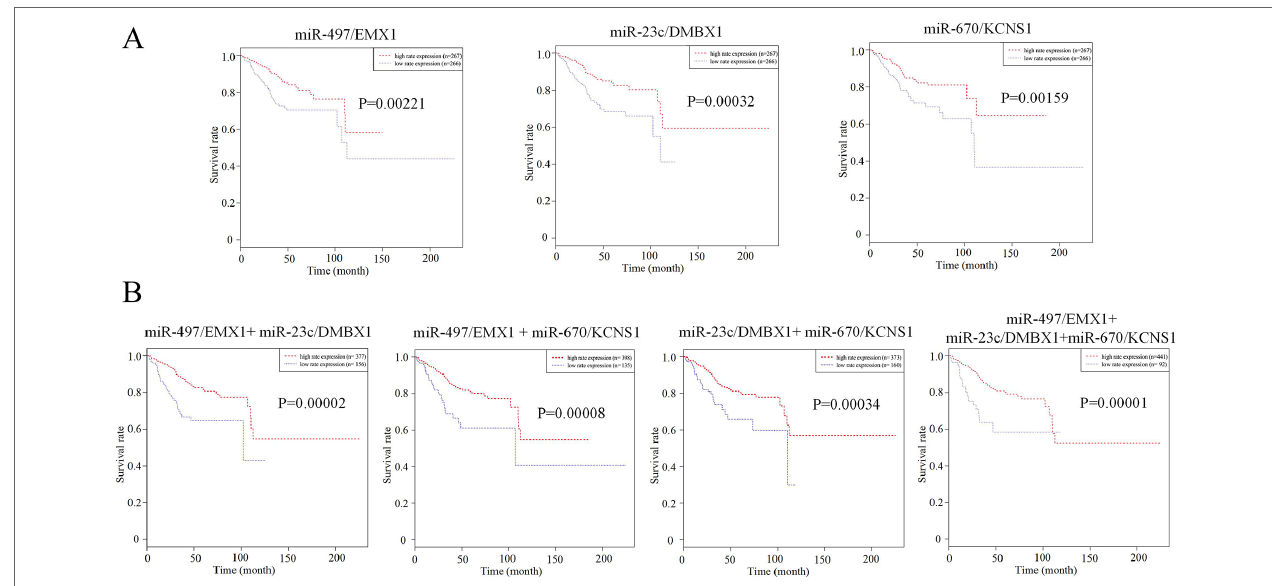
FIGURE 6 | Prediction roles of identified DE miRNAs and their potential targeted mRNAs associated with survival. (A) Kaplan–Meier curves for patients with rate of three single paired miRNA/mRNA (miR-497/EMX1, miR-23c/DMBX1, and miR-670/KCNS1) expression. (B) Kaplan–Meier curves for patients with simultaneous presence of rates for more than one miRNA/mRNA pair among these three selected pairs. The median rate of miRNA/mRNA expression was used to divide groups into low and high rates.